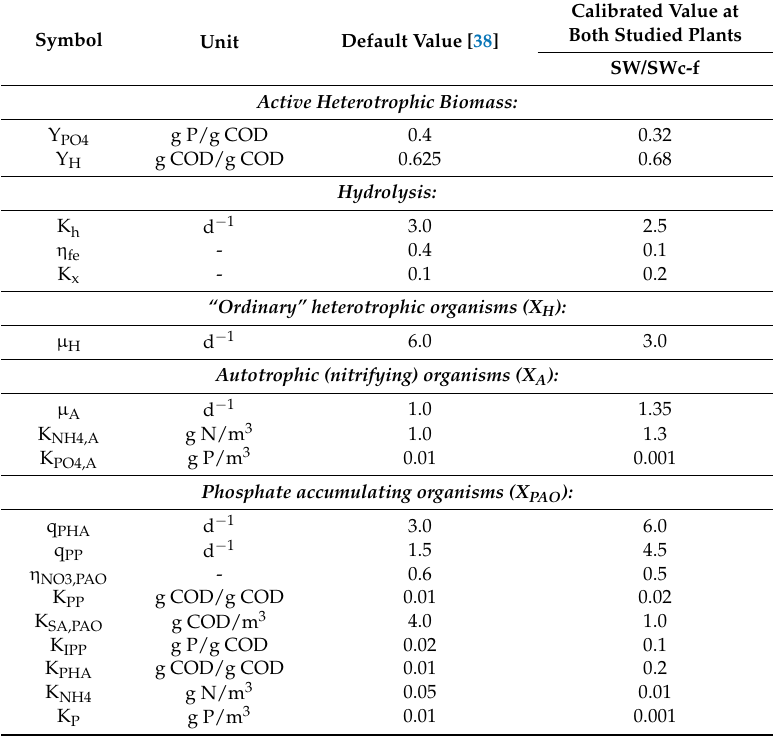
Table 3. List of default values of stoichiometric/kinetic parameters in ASM2d, and the values adjusted during model calibration at both studied plants.